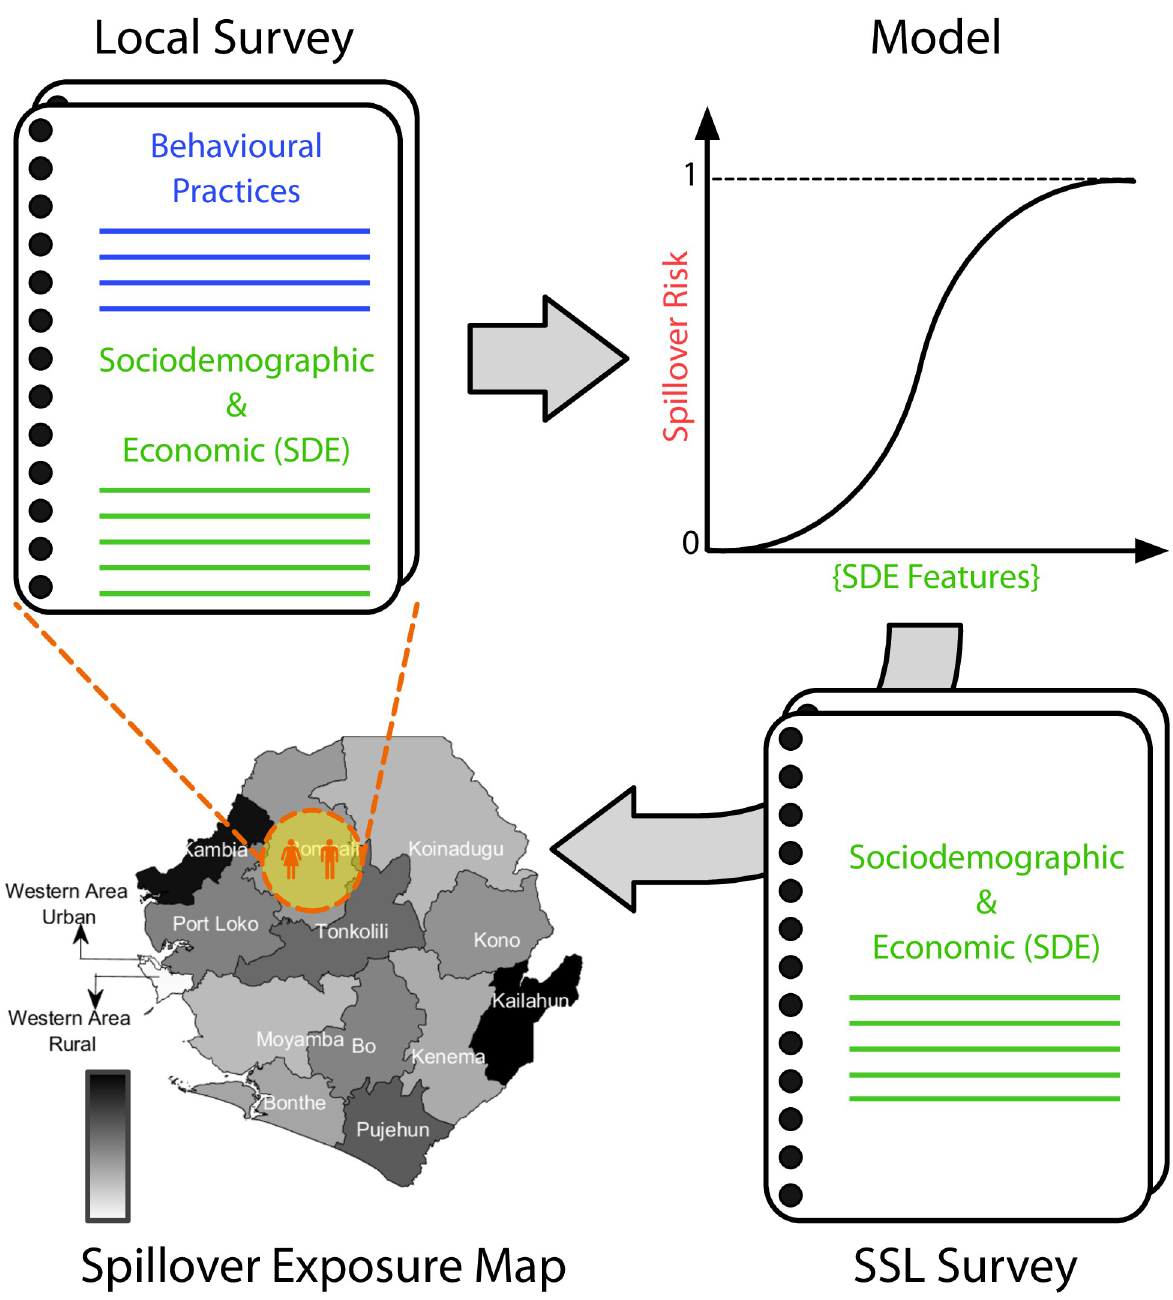
Fig 1. Methodological pipeline. We designed a survey that combines questions about behavioral practices that could expose individuals to Ebola infection and questions to measure sociodemographic and economic (SDE) factors. The survey was administered in Sierra Leone in the Bombali rural region. We analyzed our data by different means and developed a regression model that measures the spillover risk probability as a function of a number of SDE features. Once the model was calibrated, we extrapolated the results at the national level using surveyed data from Statistics Sierra Leone (SSL) to generate the infection spillover exposure